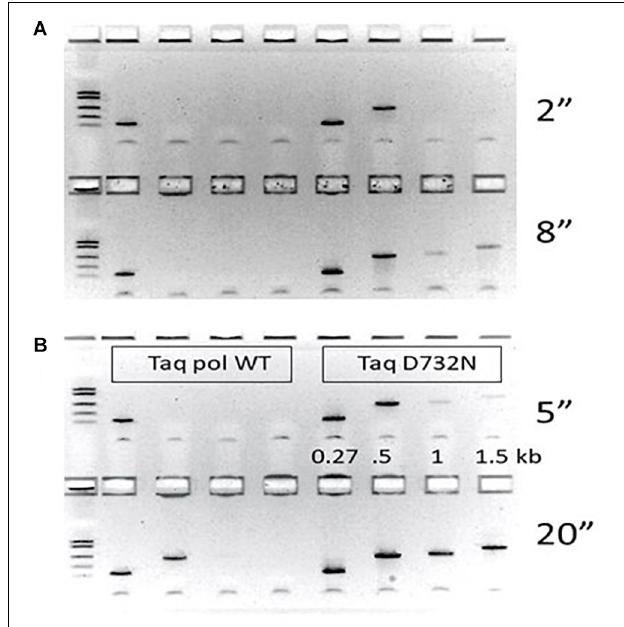
FIGURE 1 | PCR speed tests. PCR performance of wild-type Taq pol on the left half of each agarose gel is compared to TaqD732N on the right half. The gap size (distance between 3 (cid:48) -ends of the primer pairs) was 270, 502, 1000 or 1500 as labeled. Thermal cycler machine settings for annealing/extension time in seconds was tested in pairs with the shorter time on the top half of each gel. (A) 2 and 8 s (B) 5 and 20 s. Other timings 1, 10, 15, 18, 25, and 30 s are shown in Supplementary Figure 2